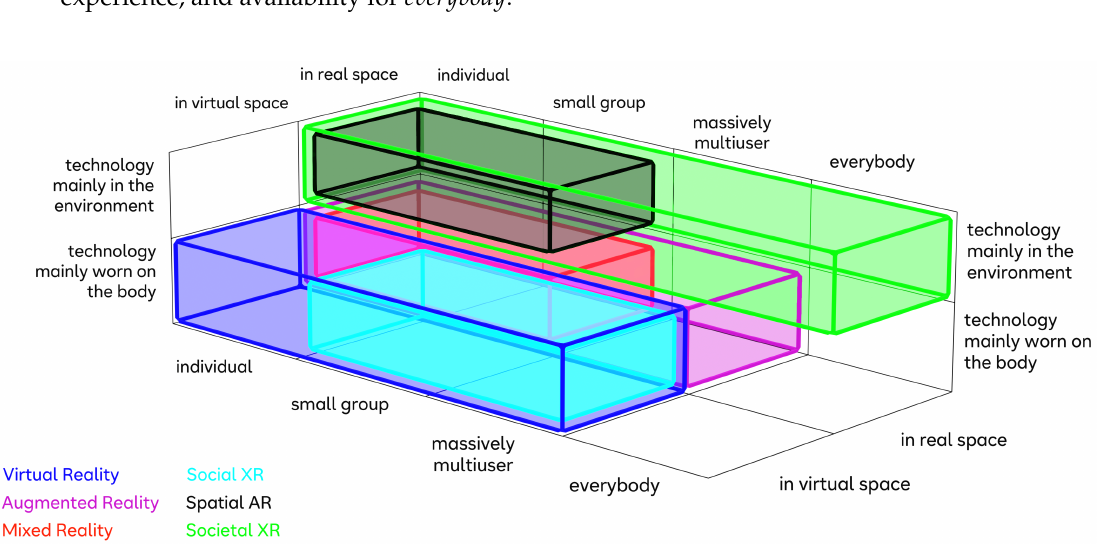
Figure 1: Three-dimensional categorization of XR paradigms with respect to technology (mainly on or off the user’s body), space (virtual or real), and accessibility (number of potential users). Societal XR is highlighted in